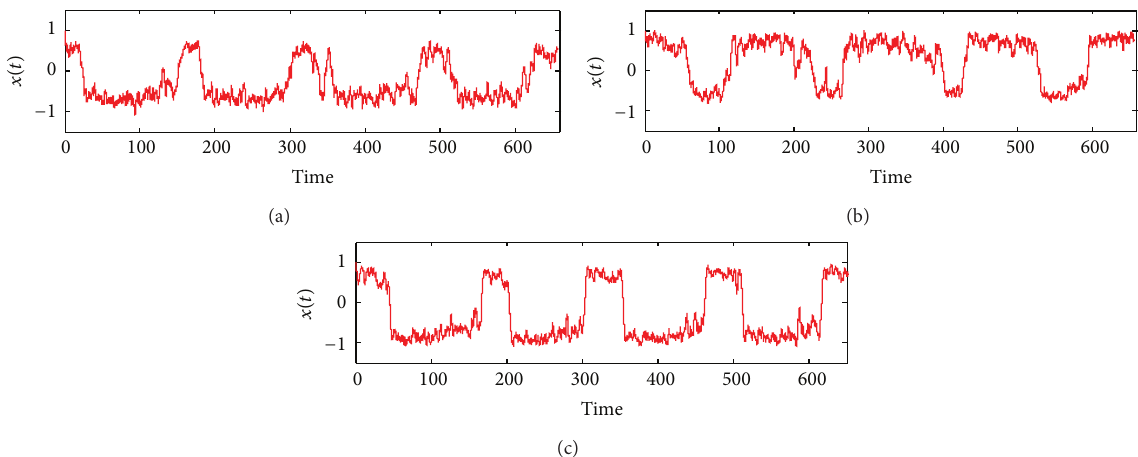
Figure 2: The system responses of the overdamped bistable system for different states values of the asymmetric dichotomous noise (a) 𝑎 = 4.0, 𝑏 = −2.0 , (b) 𝑎 = 2.0, 𝑏 = −4.0 , and (c) 𝑎 = 3.0, 𝑏 = −1.0 .